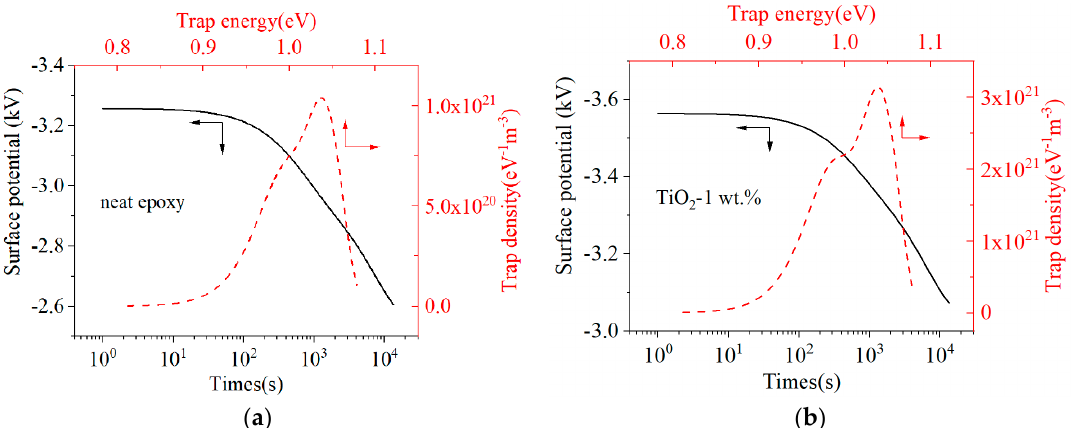
Figure 9. Surface potential decay curves and trap characteristics: ( a ) Neat epoxy; ( b ) Epoxy resin / TiO 2 -1 wt.%.